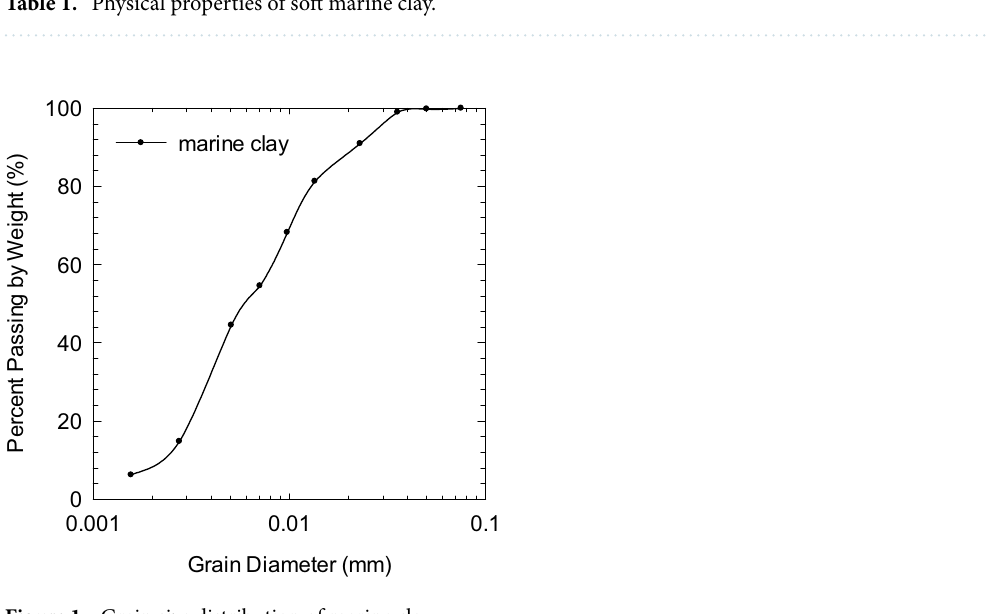
Table 1. Physical properties of soft marine clay.